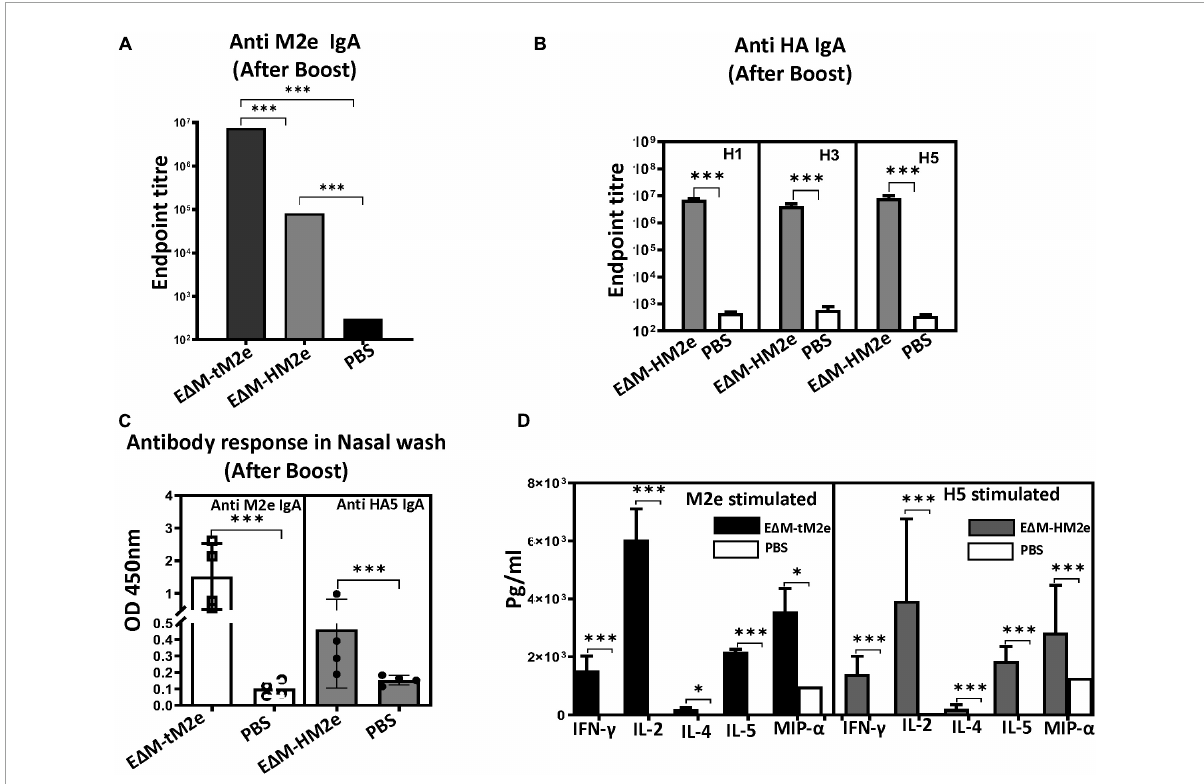
FIGURE5 The rVSV E (cid:49) M-tM2e or E (cid:49) M-HM2e induced specific serological and mucosal Anti-M2e or anti-HA IgA antibodies and mediated cell immune responses. (A) The levels of Anti-M2e IgA antibody in mice sera. (B) The levels of anti-HA (H1, H3, or H5) IgA antibody in mice sera. (C) The levels of Anti-M2e and Anti-HA IgA in the nasal wash. (D) Splenocytes were isolated from the rVSV-E (cid:49) M-tM2e- or rVSV-E (cid:49) M-HM2e-immunized mice and were stimulated with Influenza M2e peptide or HA5 recombinant protein. The release of cytokines and chemokines in the supernatants of cell cultures were quantified with an MSD V-plex kit mouse cytokine kit and counted in the MAGPIX instrument. Statistical significance between the two groups was determined using an unpaired t -test, and significant p -values are represented with asterisks, ∗ ≤ 0.05, ∗∗∗ ≤ 0.001. No significance (ns) was not